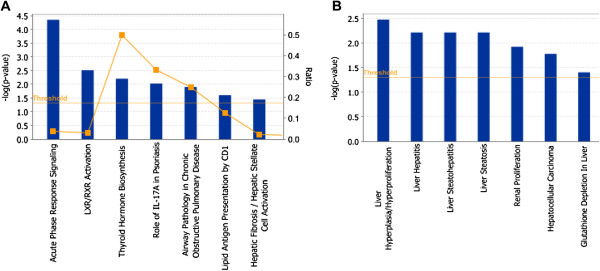
Functional analysis of the differentially expressed proteins in perfusates. A. the Ingenuity Canonical Pathway in which the greatest number of secretory proteins participated was acute phase response signaling. B. the main diseases in which the non-secretory proteins participated were liver hyperplasia/hyper-proliferation, liver hepatitis, liver steatohepatitis, liver steatosis and hepatocellular carcinoma.